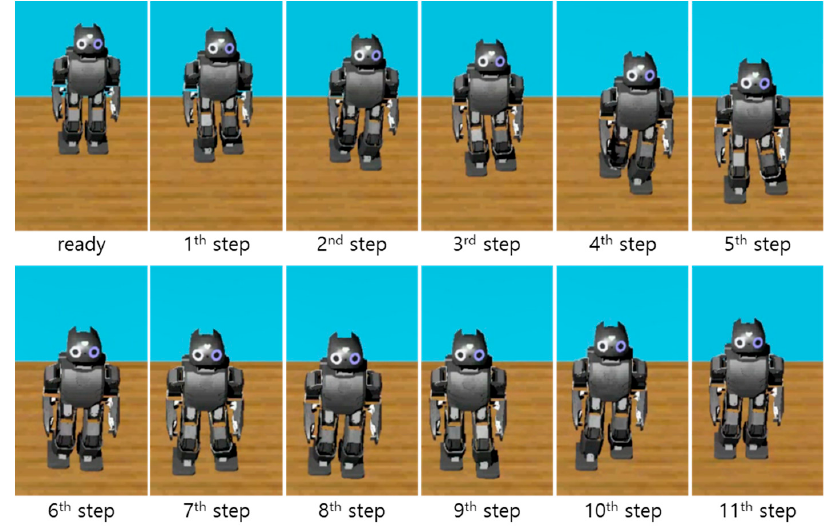
Figure 5. Snapshots of the first simulation result with the proposed CP-based walking stability controller (left to right, top to bottom).